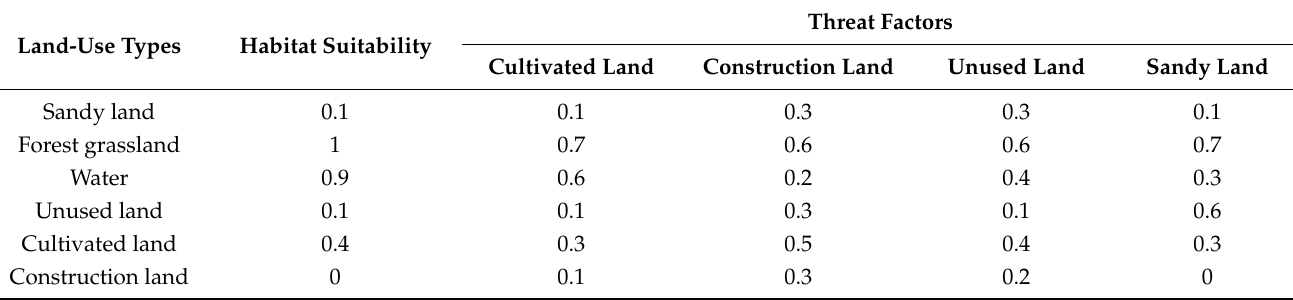
Table 3. Sensitivity of different land-use types to habitat threat